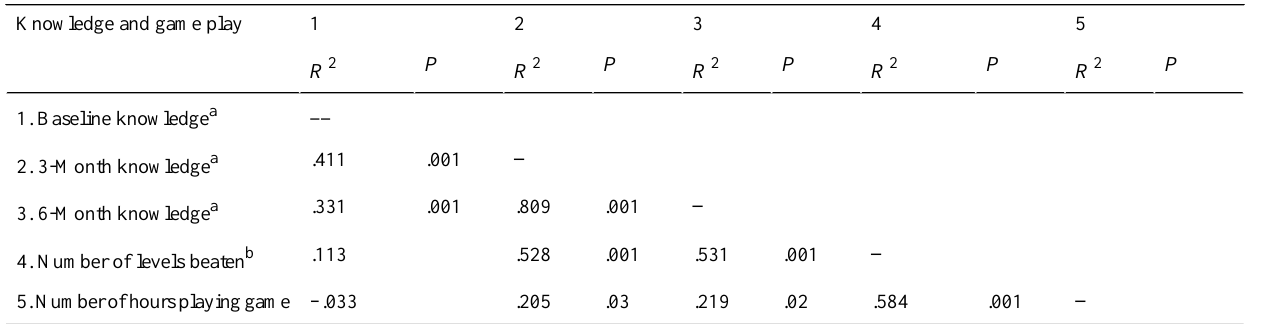
Table 2. Relationship between knowledge and game play variables. 54321Knowledge and game play